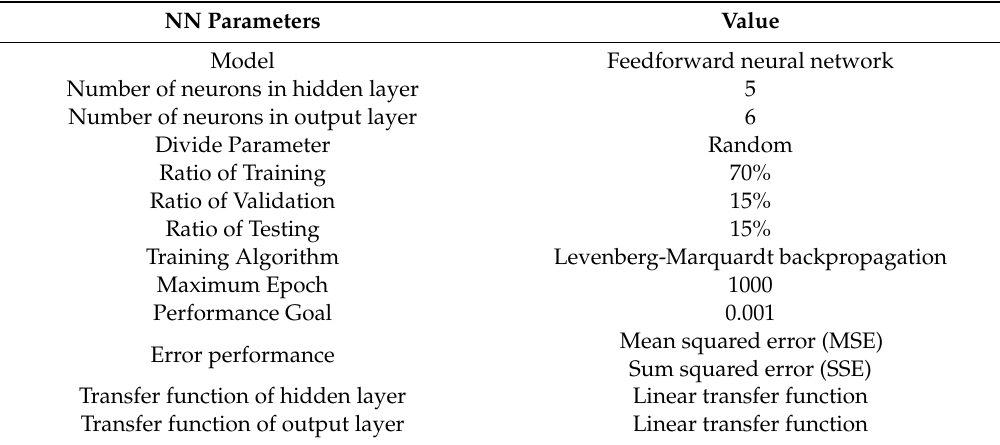
Table 2. Utilized neural network regression